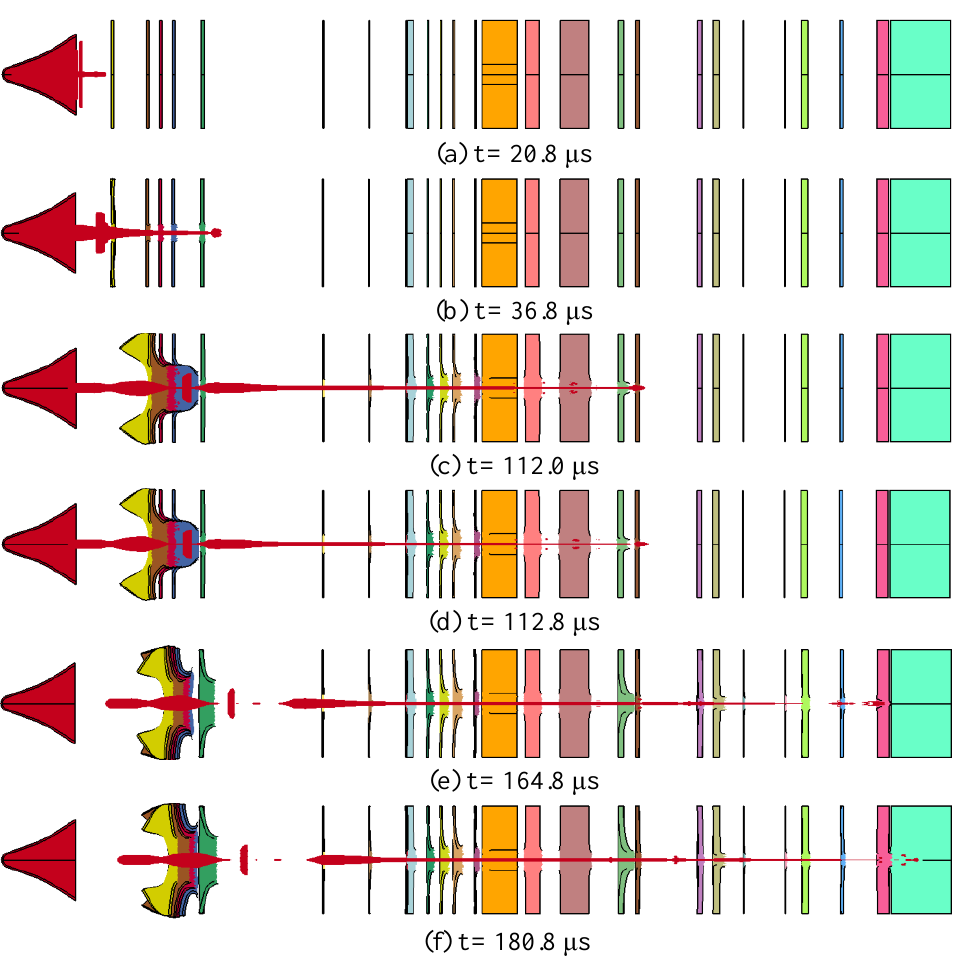
Figure 8. Penetration result with the simulation cabin.